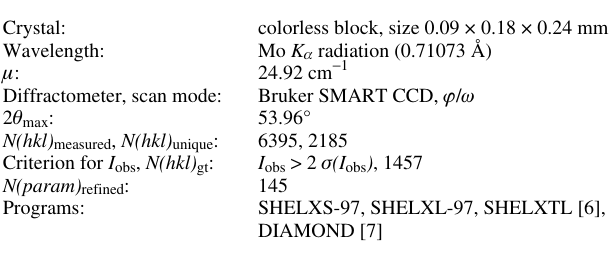
Table 1. Data collection and